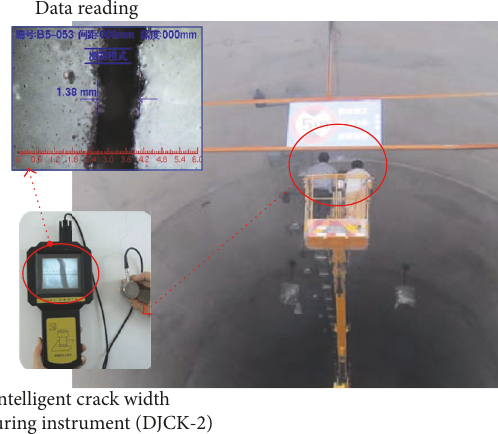
Figure 3: Liner crack width detection for Shitigou